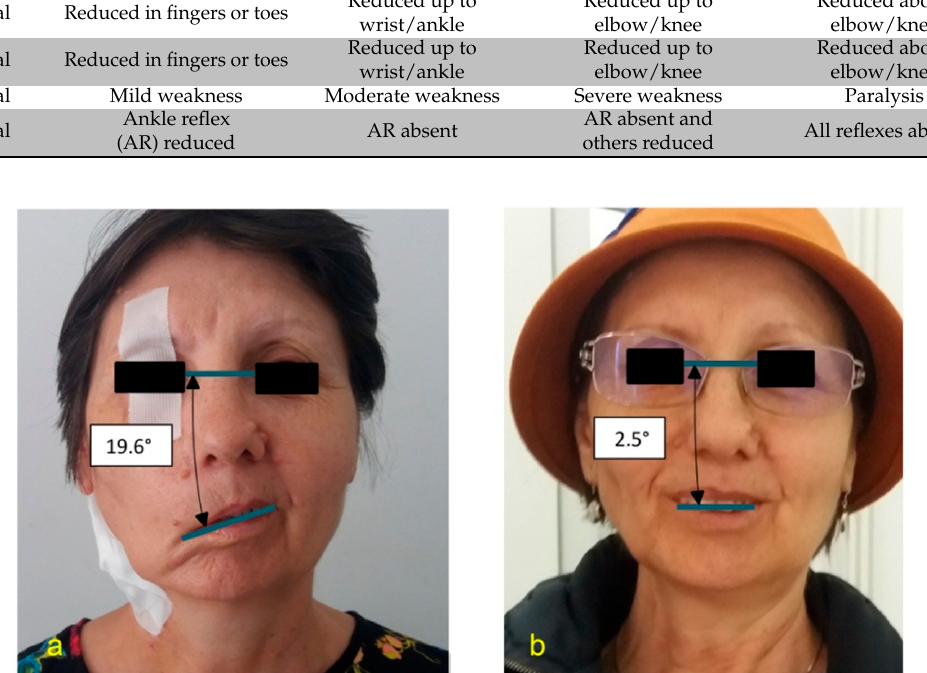
Figure 9. Measurements of facial asymmetry ( a ), HB grade VI right facial palsy—first patient before discharge after anastomosis, and symmetry ( b ), HB grade III right facial palsy—first patient after 16 months using the angle of the interpupillary and the intermodiolar line (pupillo-modiolar angle).